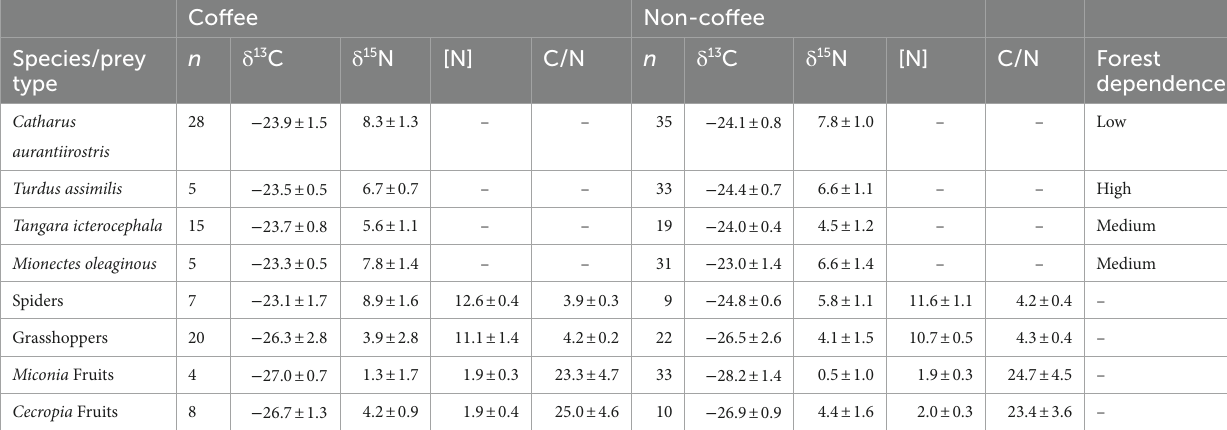
TABLE 1 Mean (±SD) δ 13 C and δ 15 N values and the sample sizes of tail feathers of four bird species and potential food sources collected in coffee and non-coffee habitats. Coffee